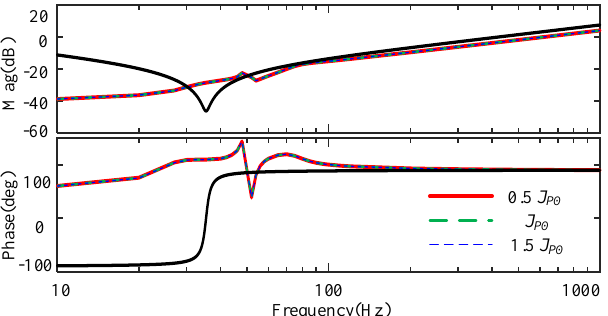
Figure 11. Bode diagram of different inertia of active power. Red line: 0.5 J P 0 ; green dash line: J P 0 ; blue dash line: 1.5 J P 0 .